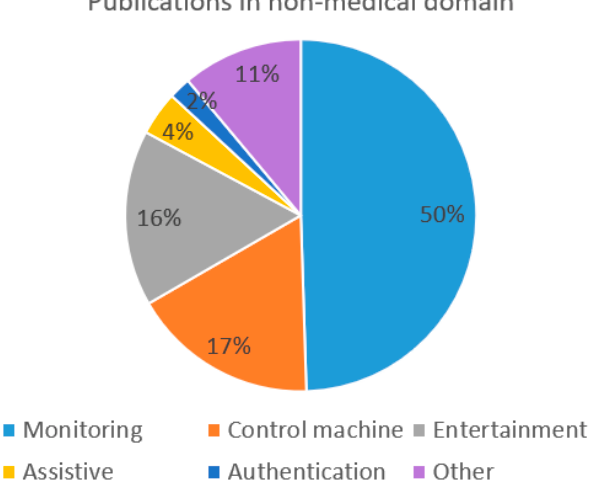
Figure 7. Distribution of publications in non-medical domain. In the non-medical domain, the largest field is monitoring followed by control machine, entertainment and other smaller fields.